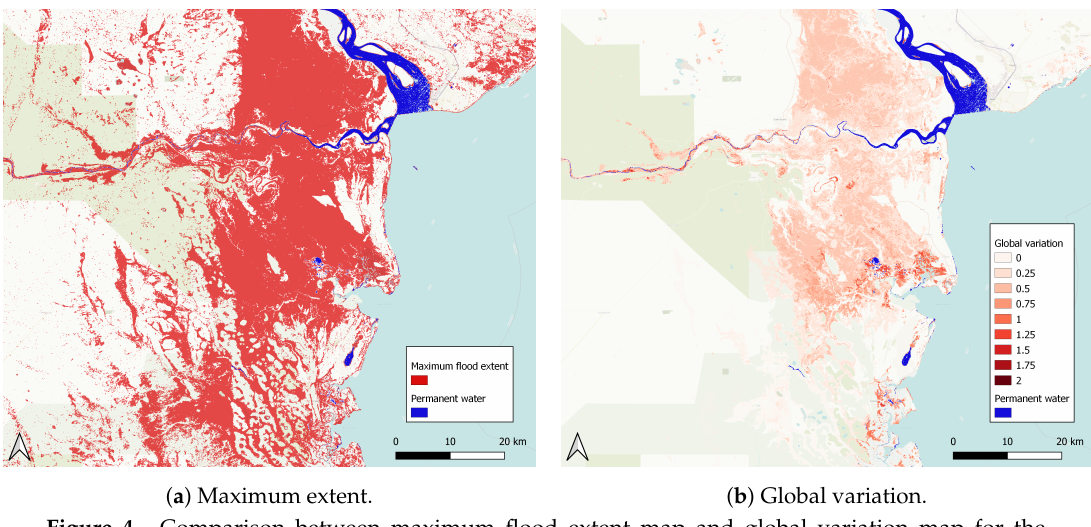
Figure 4. Comparison between maximum flood extent map and global variation map for the Mozambique flood.